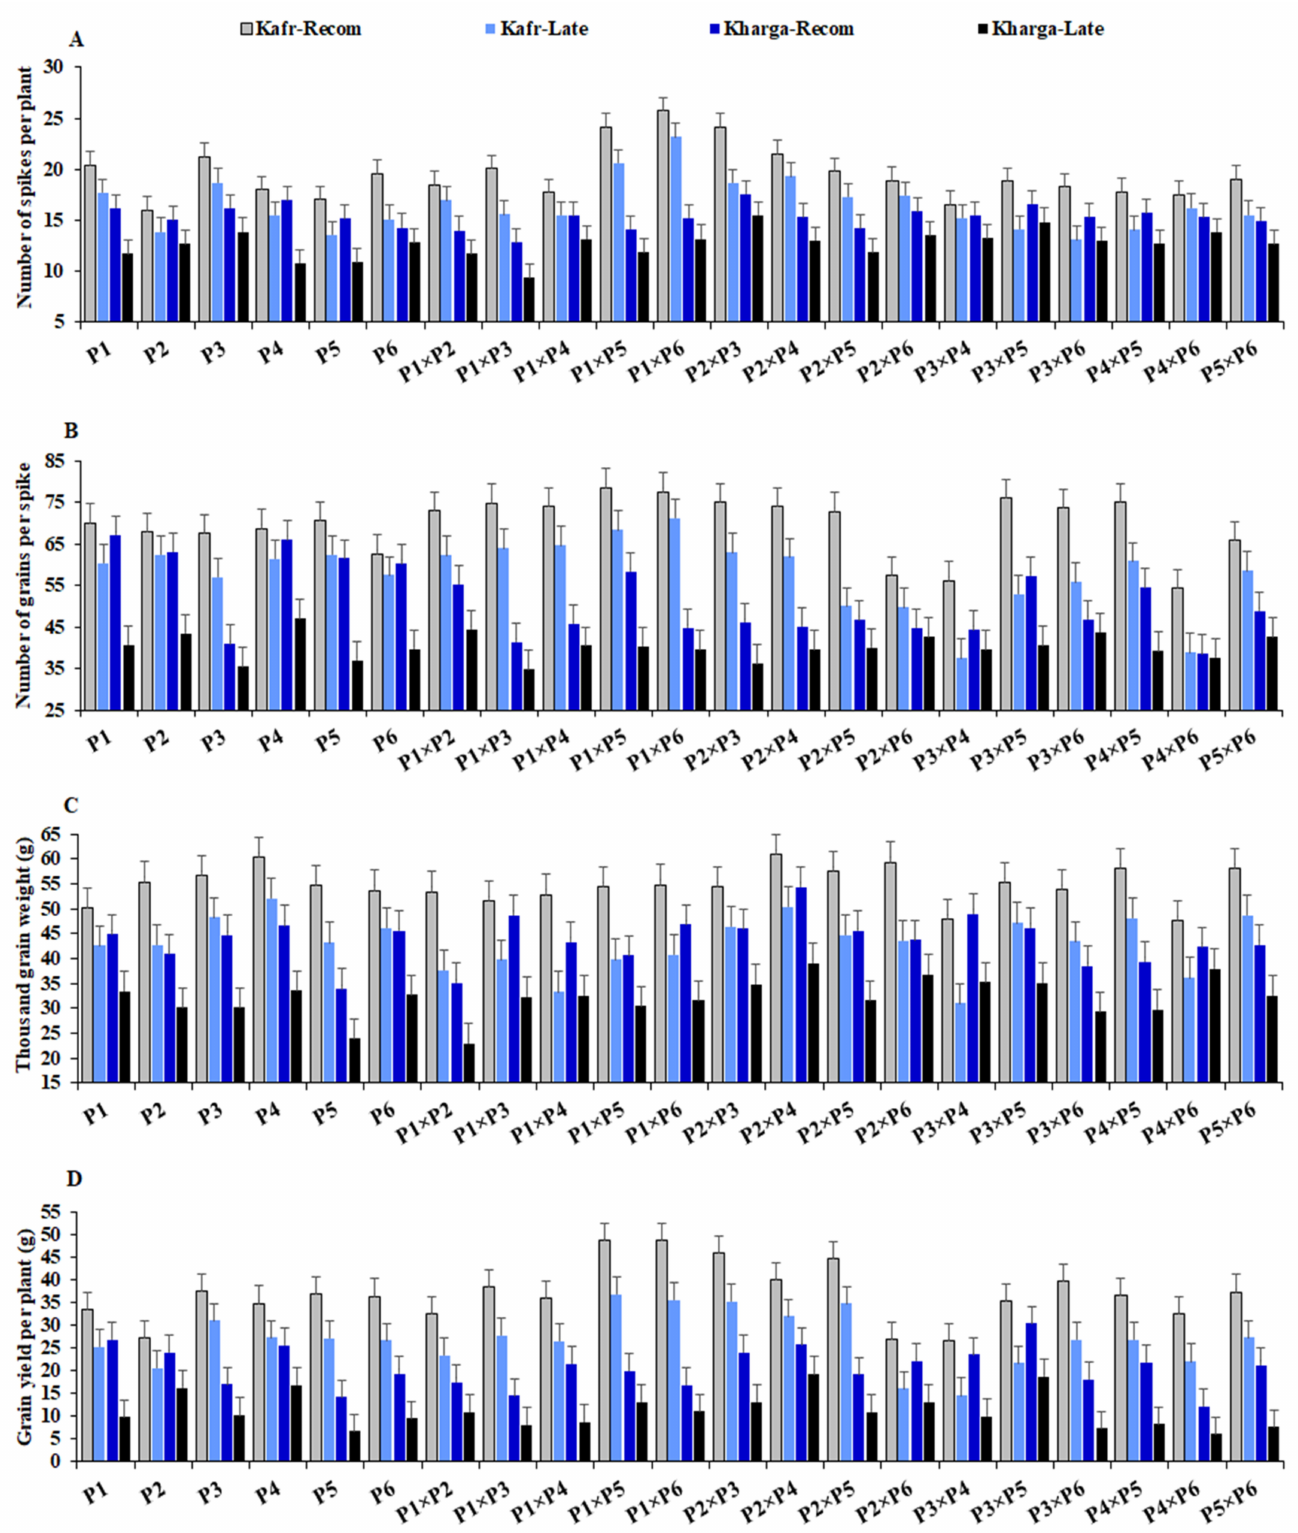
Figure 4. Mean performance of the 21 wheat genotypes the for number of spikes per plant ( A ), number of grains per spike ( B ), thousand grain weight ( C ), and grain yield per plant ( D ). The bars on the top of the columns correspond to LSD ( p ≤